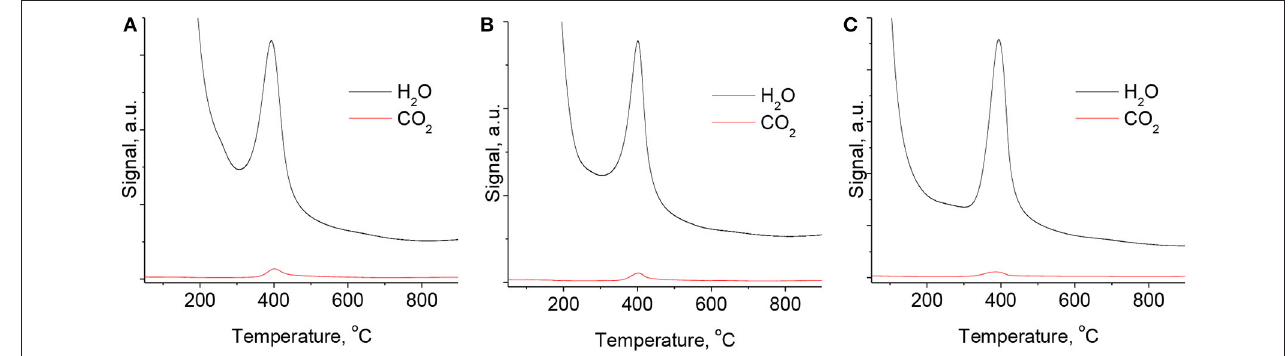
FIGURE 7 | TGA-MS spectra for reconstructed MgGa-2R10 (A) , MgGa-3R10 (B) , and MgGa-4R10 (C) .